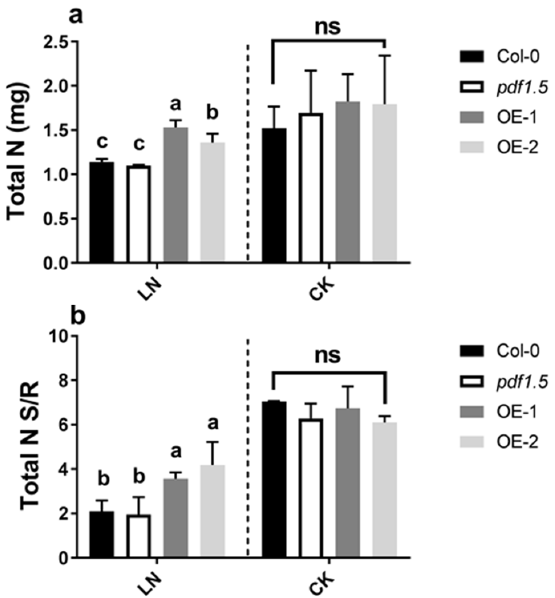
Figure 2. The involvement of AtPDF1.5 in the nitrogen uptake and distribution in low nitrogen